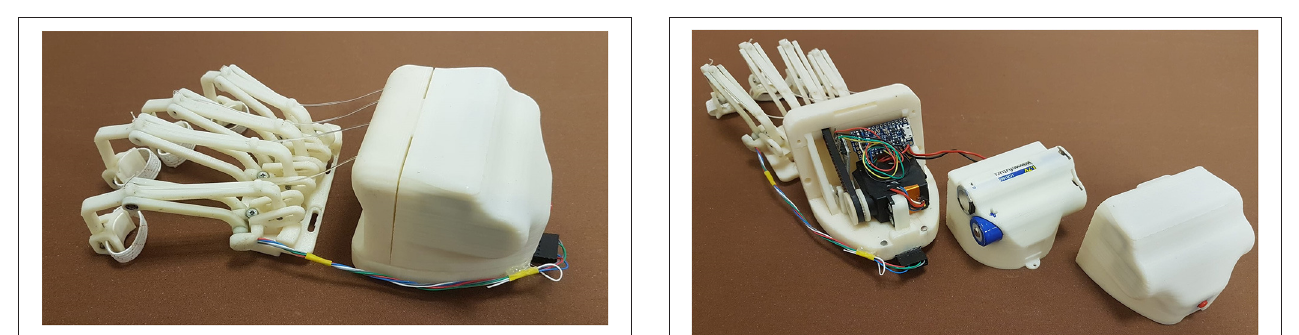
FIGURE 5 | The figure shows an exploded view of the new motor box and the three layers that compose it: on the left, the inner layer, including the transmission system, actuator, and control electronics; on the centre, the middle one containing the batteries, and, on the right, the outer one, including the switch